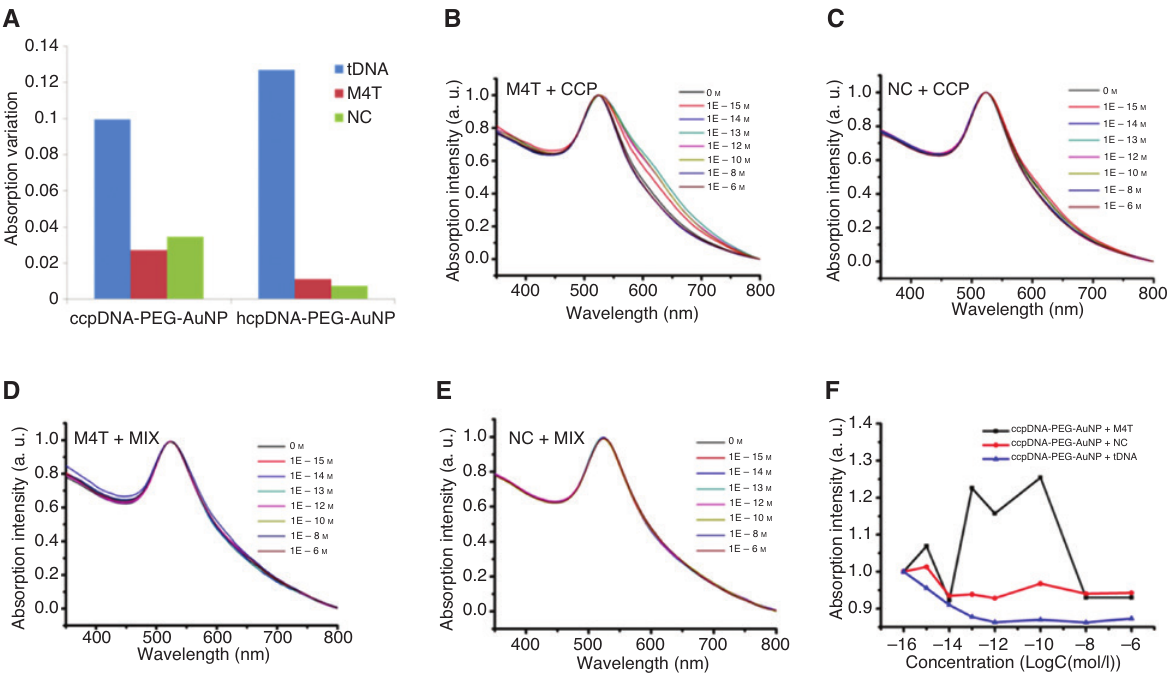
Figure 5: Specificity evaluation. (A) The intensity at 580 nm for the tDNA and the two mismatched ssDNAs and for both detection methods. (B–E) The UV-visible spectra depending on the tDNA concentration for the following experiments: (B) M4T + CCP method, (C) NC + CCP method, (D) M4T + MIX method, (E) NC + MIX method. (F) The A580 intensity versus the ssDNA concentrations. The intensities were normalised by the A580 intensity measured with no